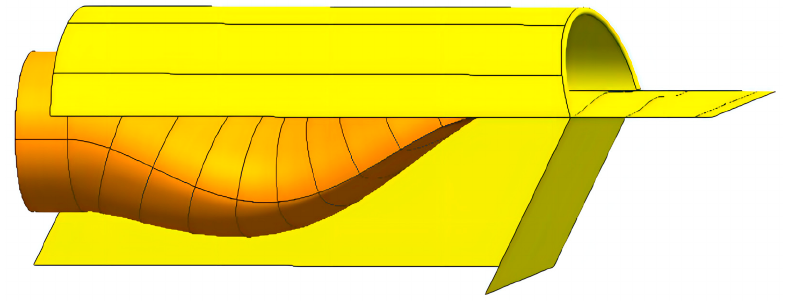
Figure 8. Intake model used for RCS calculations.